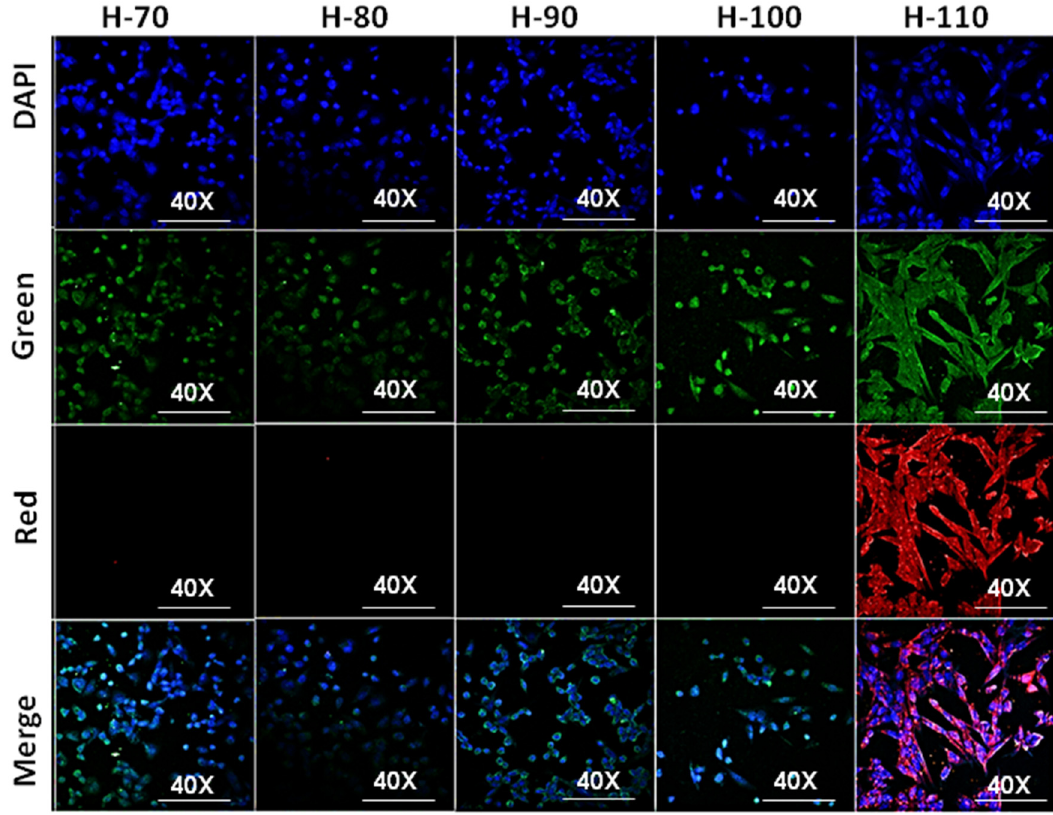
Figure 7: Confocal imaging of cellular uptake of H - 60, H - 70, H - 80, H - 90, H - 100, and H -